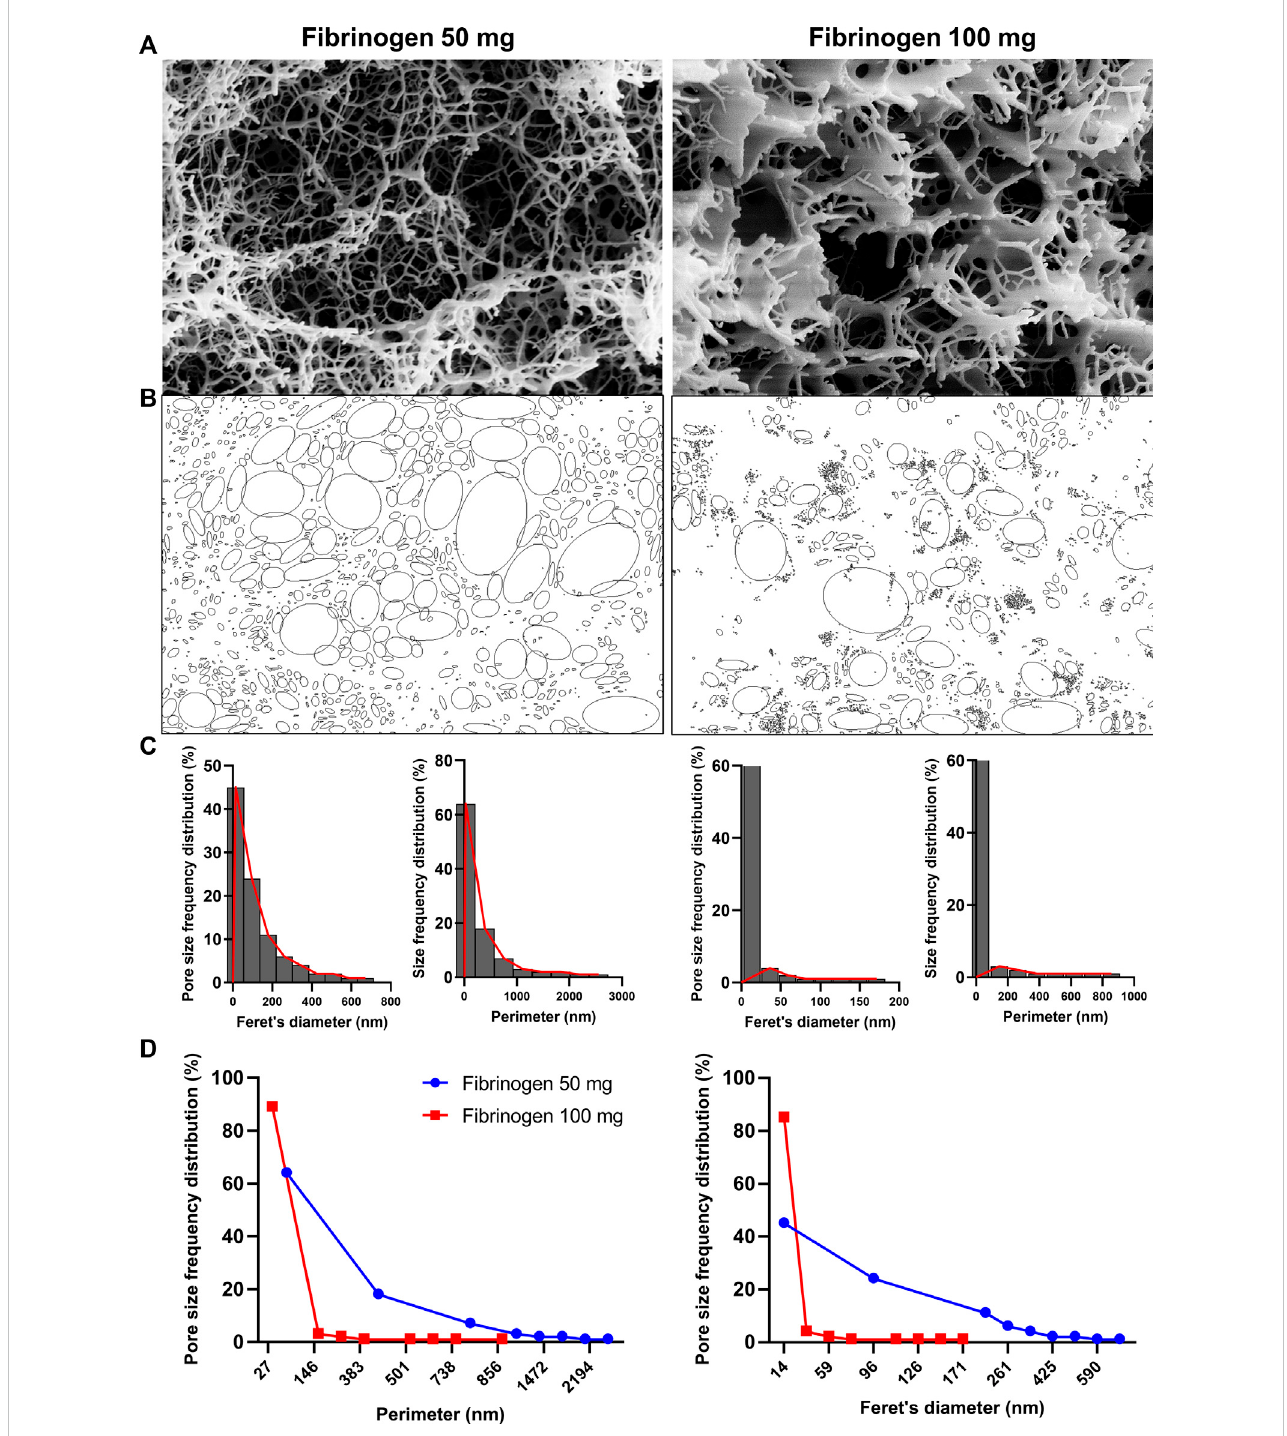
FIGURE 1 Field Emission-Scanning electron microscopy (FE-SEM) images of aerogels and of their internal structure morphology at two tested fi brinogen concentrations,100 mg/mland50 mg/mlscaffoldsweredriedbydensegasinordertoavoid3Dstructureshrinkageofaerogelthatwasclearlyobservedafter scaffold freeze-fracturing in liquid nitrogen (A); Perimeter and Feret ’ s diameter values were calculated with ImageJ software, and pores were automatically determined after threshold adjustment in 100 mg/ml and 50 mg/ml fi brinogen scaffolds (B) . Size frequency distributions are shown for perimeter and Feret ’ s diameter values in 100 mg/ml and 50 mg/ml fi brinogen scaffolds (C), and (D) compared between the two